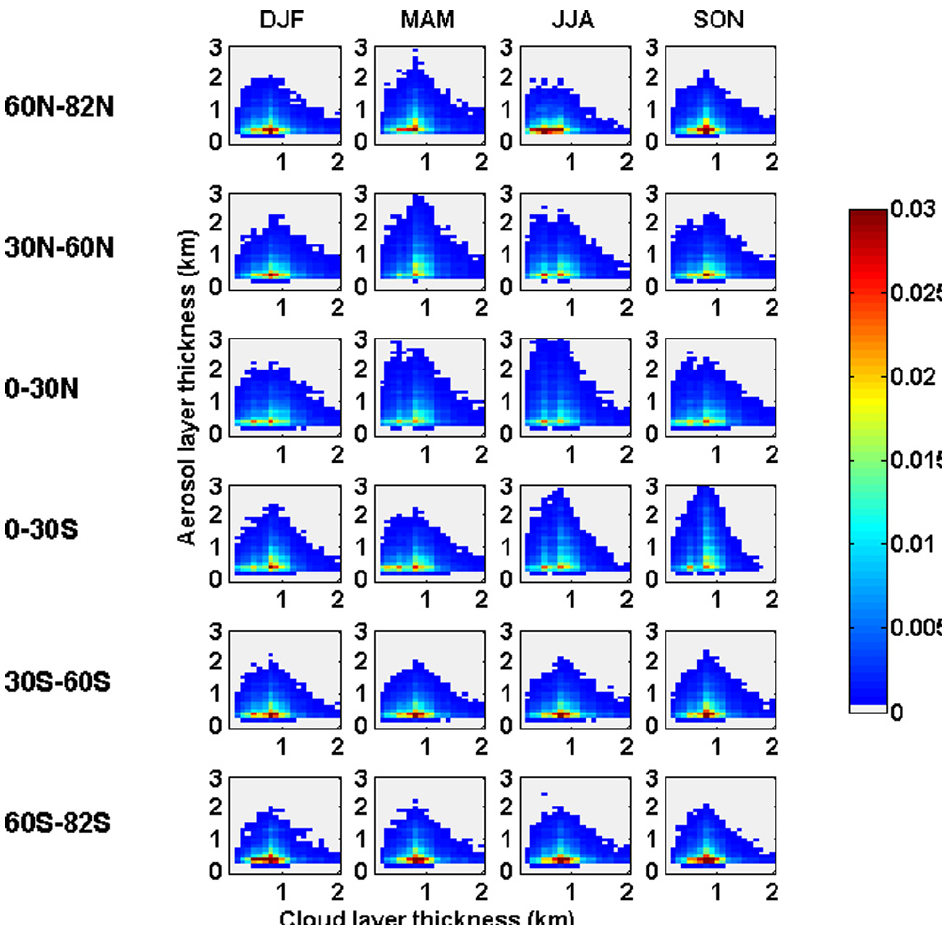
Fig. 8. Joint histograms of cloud and aerosol layer geometrical thicknesses in overlapping cases when overlap from all aerosol types is considered. The binning and normalization is same as in Fig.